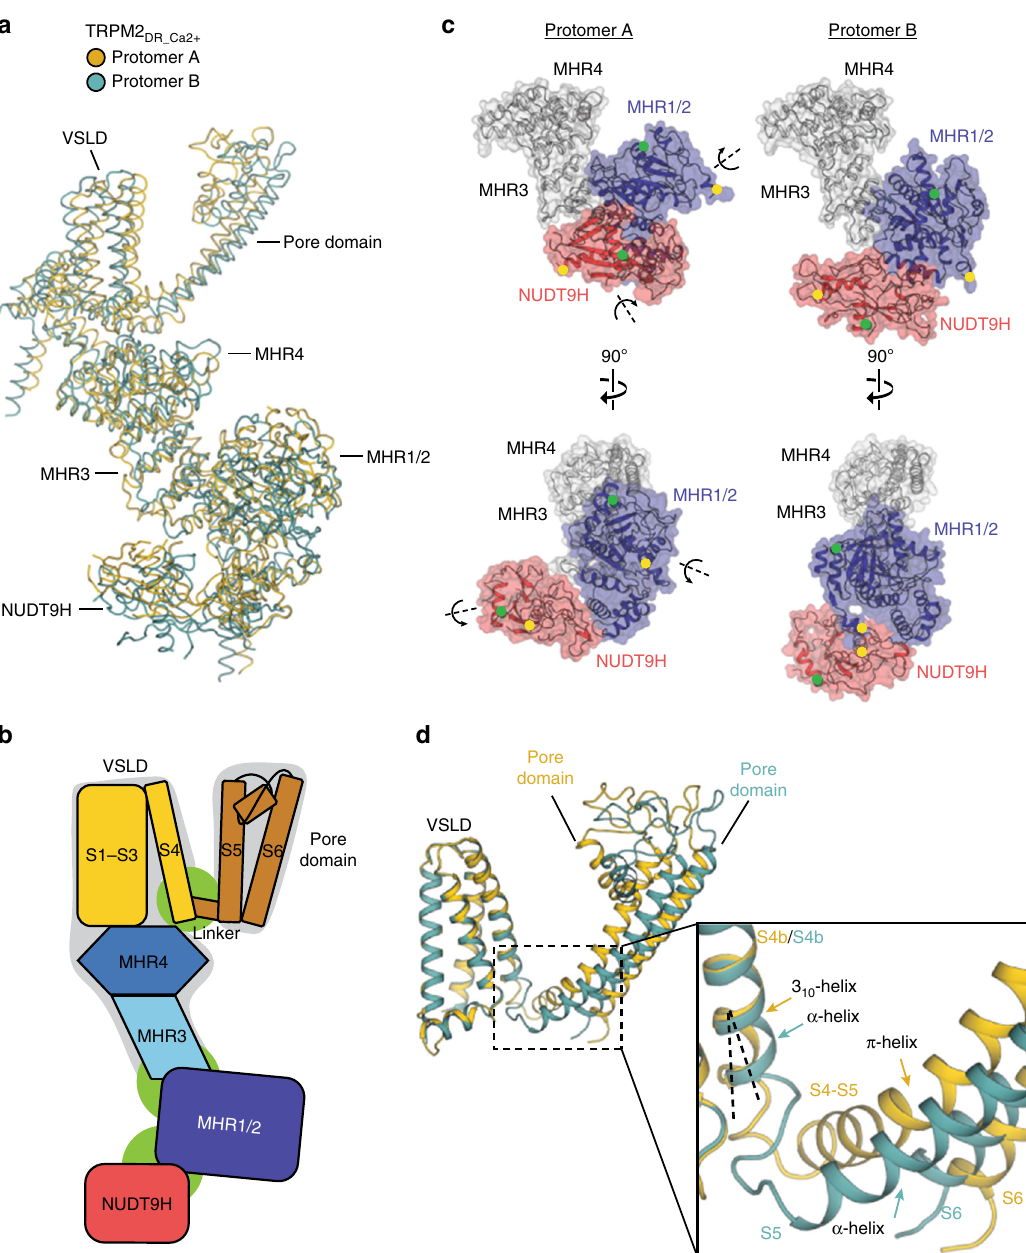
Fig. 4 Flexible junctions enable conformational heterogeneity within the channel. a Cartoon representation showing alignment between protomer A (yellow) and protomer B (teal) from the TRPM2 DR_Ca2 + structure. b Schematic diagram showing the three fl exible junctions: NUDT9H-MHR1/2, MHR1/2- MHR3, and VSLD-pore (in green), and the static region: MHR3-MHR4-VSLD and the pore domain (in gray). The pre-S1 domain, TRP domain, and C- terminal helices are omitted for simplicity. c Protomers A (left) and B (right) of the TRPM2 DR_Ca2 + structure aligned at MHR3 and MHR4 (gray). Side-by- side surface representations indicate that the rotations of MHR1/2 and NUDT9H in protomer A around individual axes (left) lead to the orientations observed in protomer B (right). D90 (yellow) and Q137 (green) from MHR1/2 and V1372 (green) and A1467 (yellow) from NUDT9H are denoted as dots in both protomers. d Protomers A (yellow) and B (teal) of the TRPM2 DR_Ca2 + structure aligned at VSLD. Close-up view shows the structural divergence occurring at the S4b and the S4 – S5 linker regions, giving rise to different con fi gurations of the pore